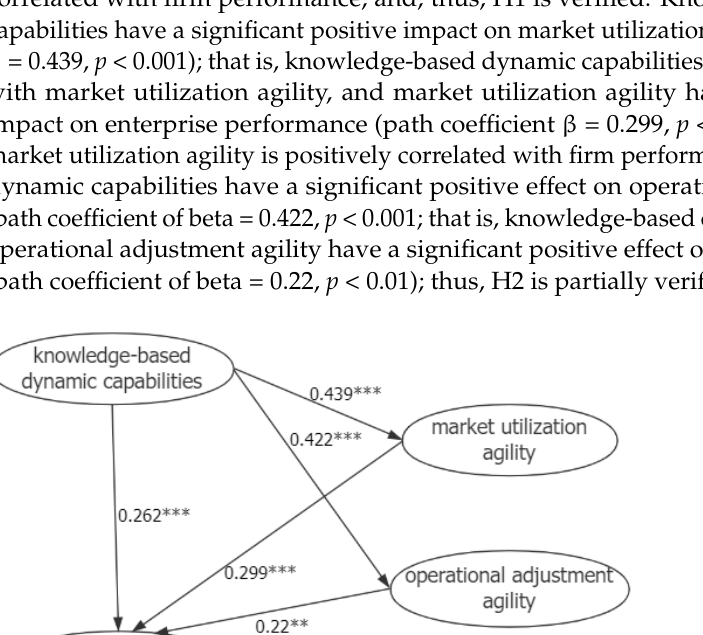
Table 5 . Mediating Effect Test Table (N = 229).